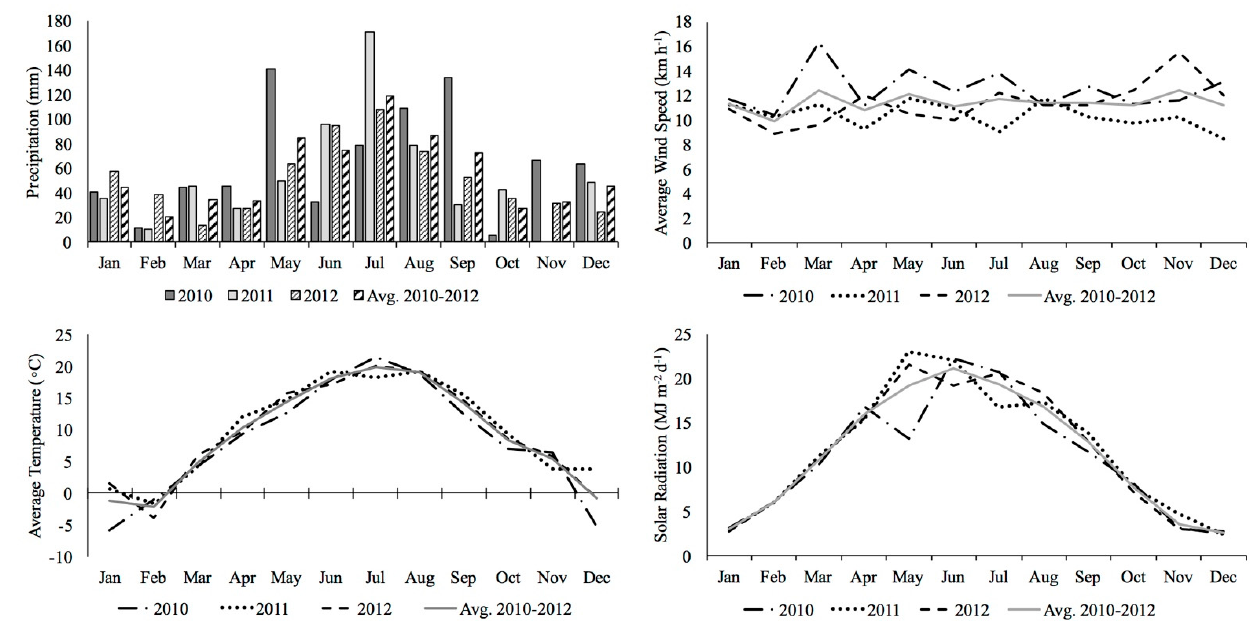
Figure 1. Precipitation, average wind speed, average temperature and solar radiation between January 2010 and December 2012 in Wroclaw, Poland (1 km from experimental plantation).